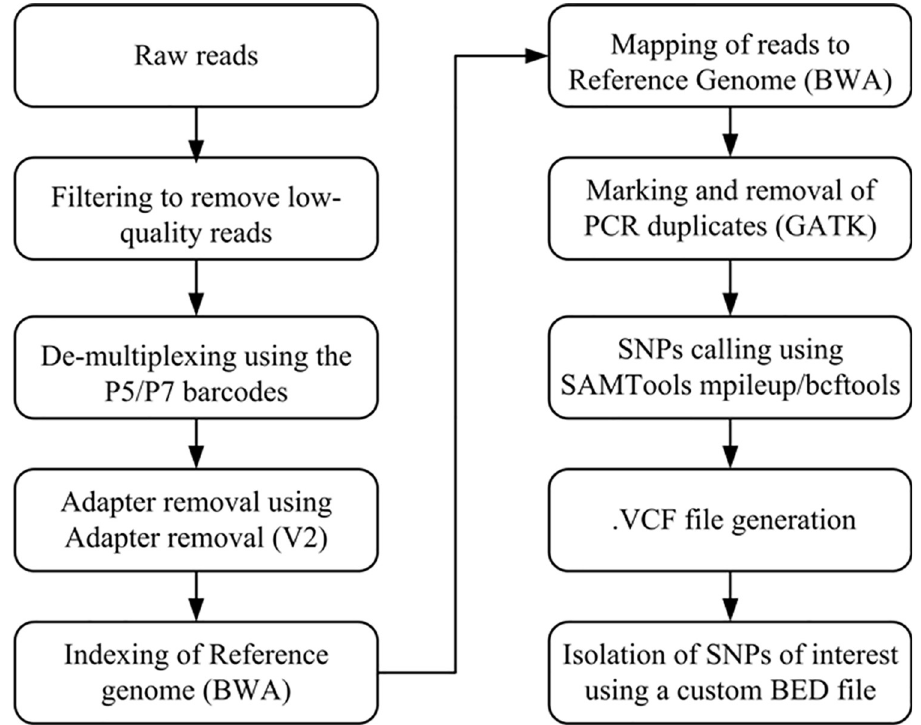
Fig 2. Workflow highlighting main steps of sequencing data analysis